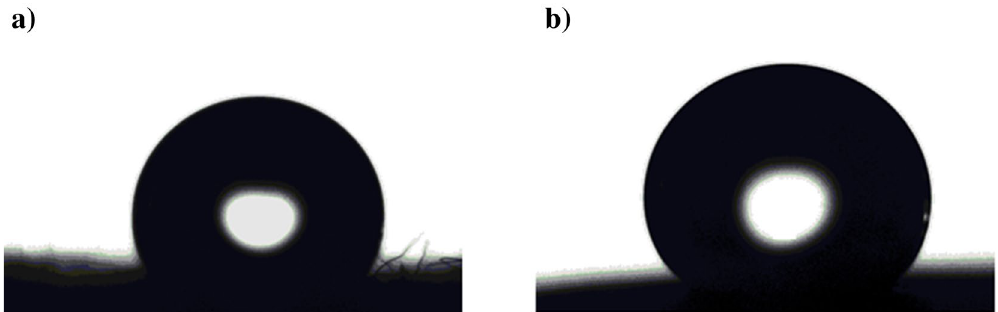
Figure 11. The shape of a water droplet on SHP coated steel by ( a ) Ni@G@MA, and ( b ) Ni@Cr-G@MA after the mechanical abrasion